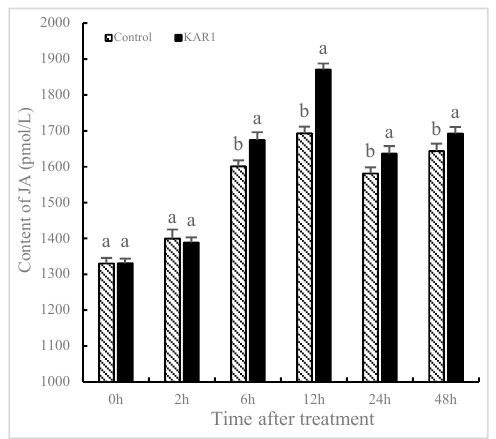
Figure 3. Time courses of jasmonic acid level of S. miltiorrhiza hairy root. The roots treated with KAR 1 were harvested at determined time points. JA contents of the root were then determined. Data are means of three replicates ± SD. Different letters indicate significantly different values according to one-way ANOVA followed by Tukey’s test ( p < 0.05).